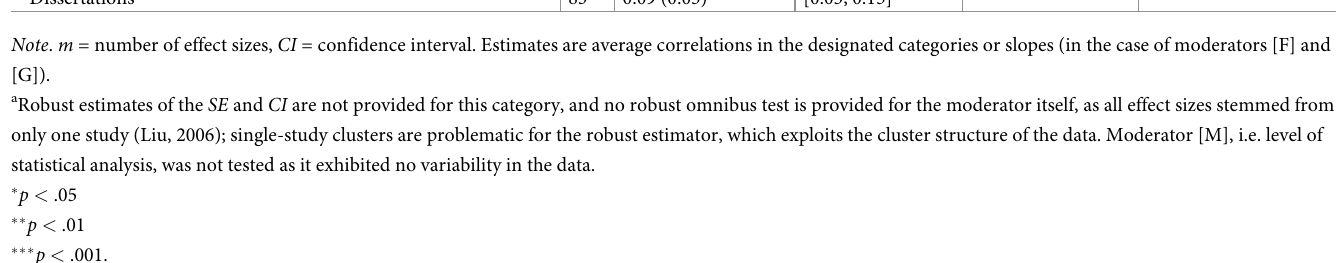
meta-analysis. A funnel plot of all effect sizes is presented in Fig 2. Some effect sizes were visi- bly oriented along curved lines in this plot. This was caused by clusters of effect sizes, which stemmed from the same studies (e.g., the ostentatious line at the top of the funnel plot extend- ing to the right shows the 24 effect sizes of Haj-Yahia and Abdo-Kaloti [47]). Other than this, there was no obvious visual indication of effect-size asymmetry. Yet, the above result on evi- dence of negative correlations being more likely for dissertations may indicate some bias in peer-reviewed publications nonetheless.